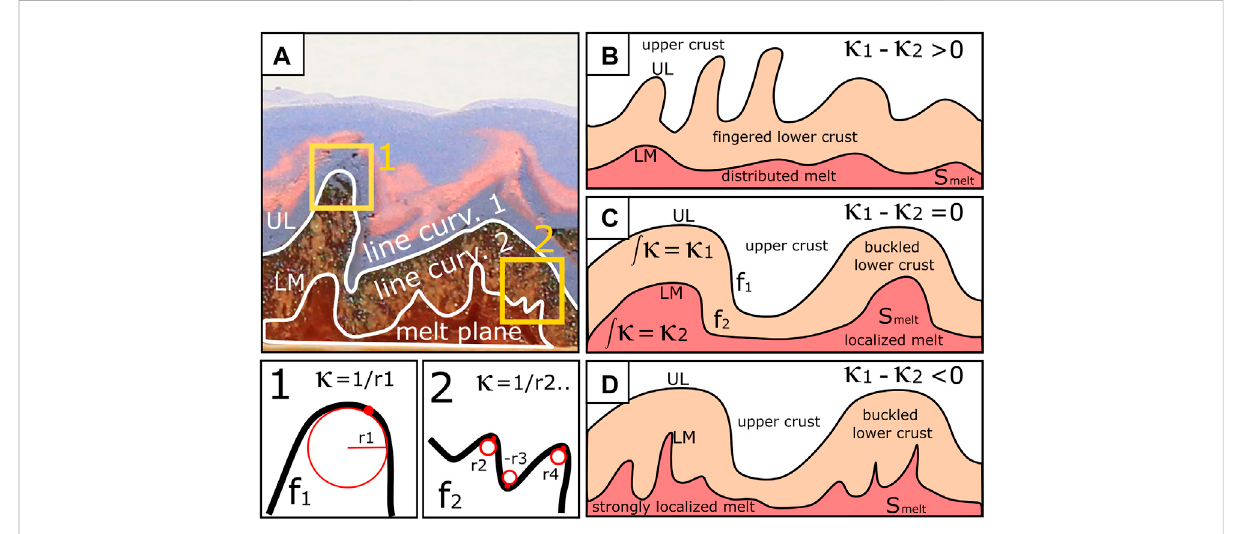
FIGURE 3 Principlesofmeltdistributionandcurvatureanalysis.Interfacesbetweenmodellayers(UL,LM)aretracedusingthe ImageJ (Fijisoftware) (A) and theirlinecurvature( κ =1/r )iscalculatedfordiscretepointsoftheindividualcurves(thecurvatureisindirectlyproportionaltoradiusofacirculararcor osculating circle). Examples of three contrasting scenarios according to the differences in curvature for the upper-lower crust and melt-lower crust interface (B – D) .The fi rstscenariore fl ectsverysmalldifferenceswhichoccurforthemeltlocalizationinasimilarmannertothegeometryofthe foldedlowercrust (B) .Thesecondscenariore fl